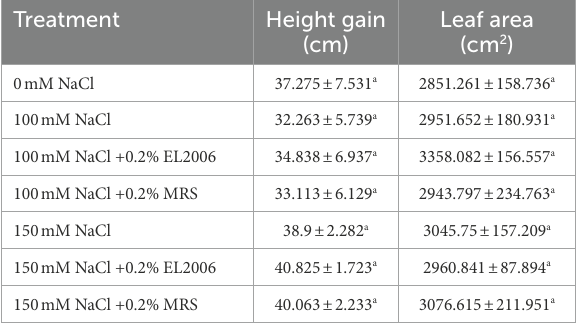
TABLE 5 Effect of treatments on selected growth variables of